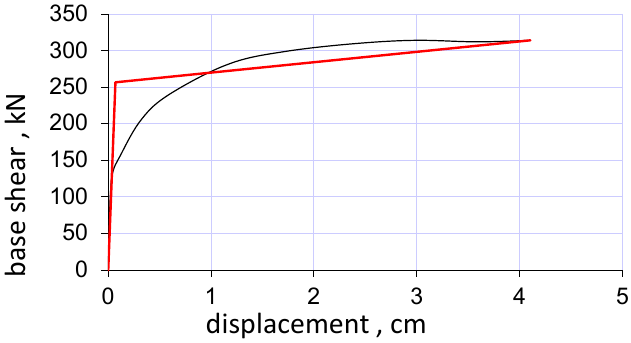
Figure 24. The two-line graph resulting from the cyclic loading curve.